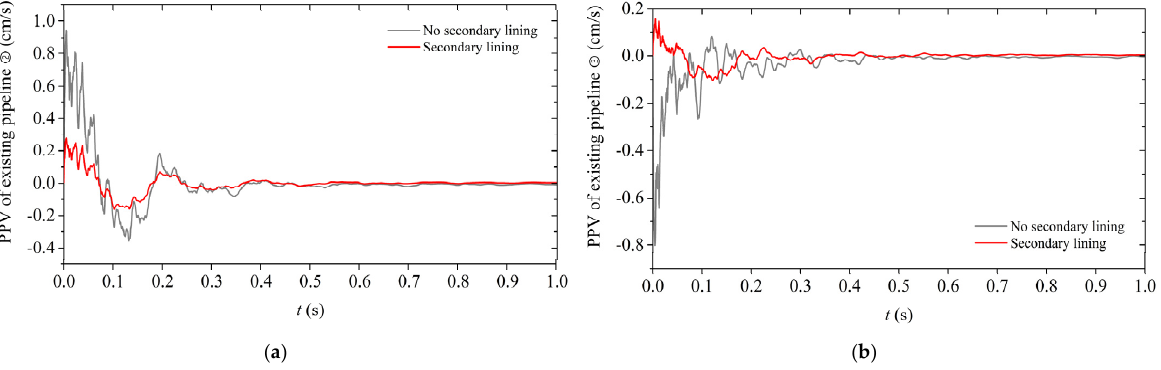
Figure 13. Blasting the lower rock with and without secondary lining: ( a ) Existing pipeline ② ; ( b ) Existing pipeline ③ .